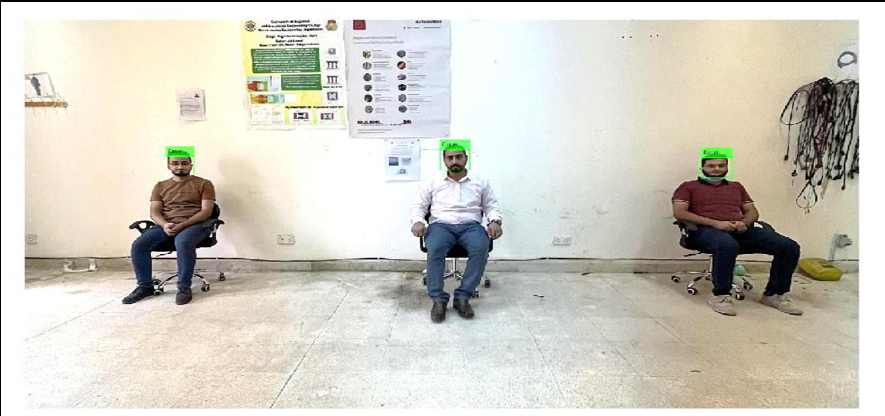
Fig. 5. Face detected by